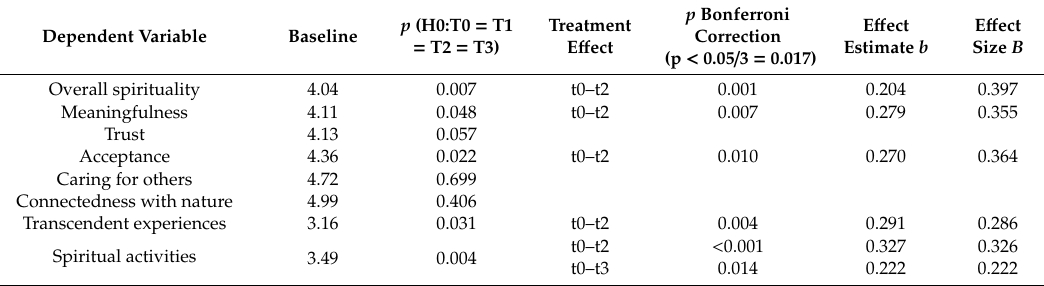
Table 6. Spirituality and Spiritual Growth (SAIL). 1, 2 .